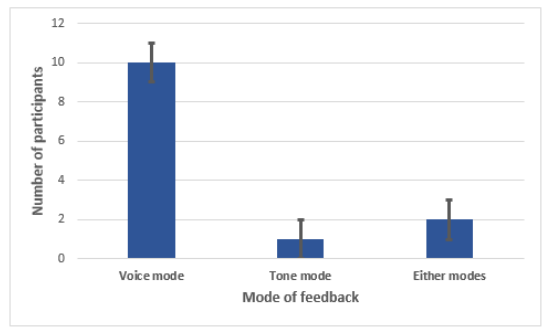
Figure 6: Users’ preferred mode of